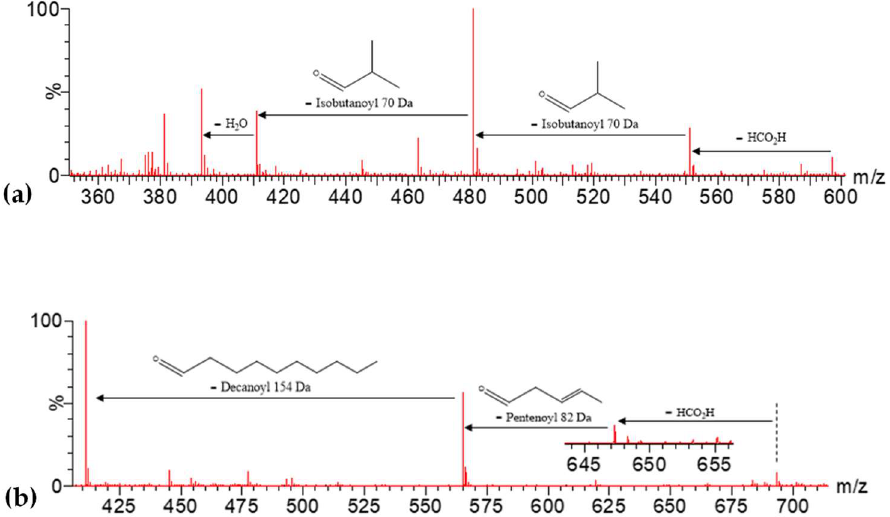
isobutanoylsucrose, O-isobutanoyl-O-methylbutanoyl sucrose and o-decanoyl-o-